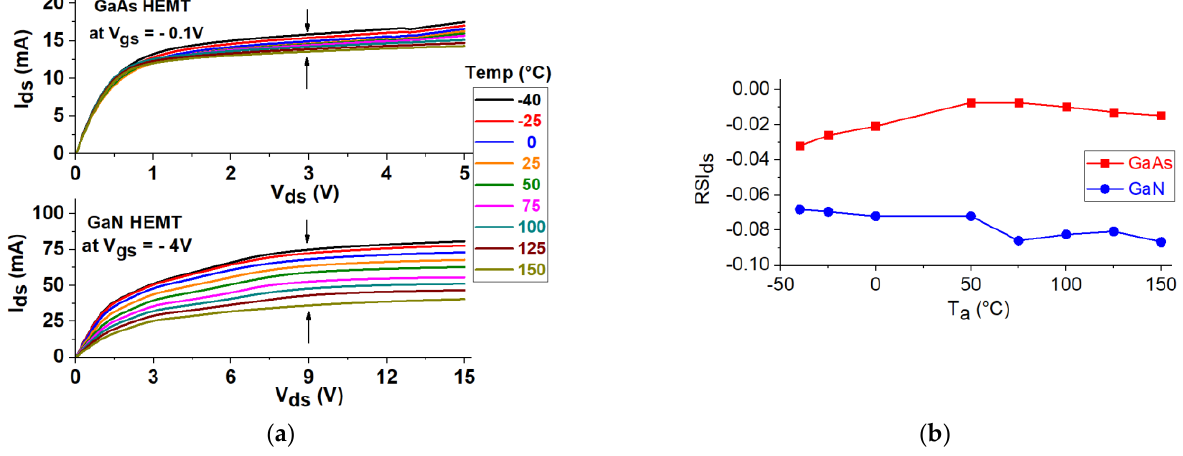
Figure 4. ( a ) The selected bias points for the sensitivity-based analysis are V ds = 3 V and V gs = − 0.1 V for the GaAs HEMT (top plot) and V ds = 9 V and V gs = −4 V for the GaN HEMT (bottom plot); ( b ) Behavior of RSI ds versus T a for the studied (red line) GaAs and (blue line) GaN HEMTs.